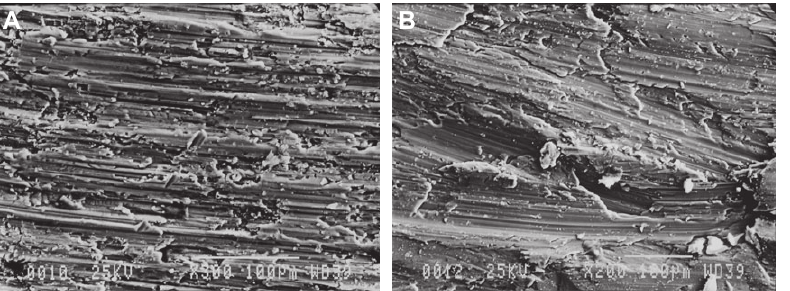
Figure 8 SEM micrographs of typical samples of wear debris generated during dry sliding of the pin samples of (A) Al-Cu composite and (B) cast aluminum.